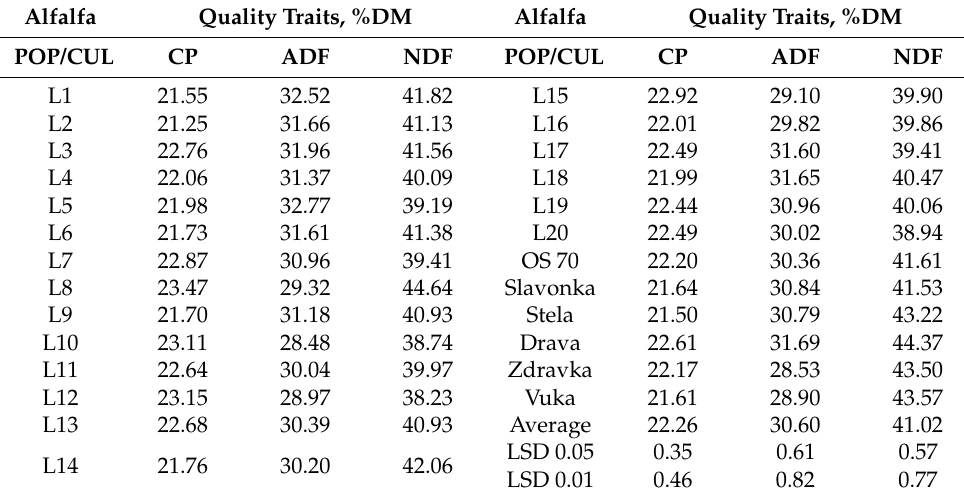
Table 2. Forage quality traits of the investigated alfalfa populations/cultivars in the second cut of the second growing season at the late bud to early flowering stage. Alfalfa Quality Traits, %DM Alfalfa Quality Traits, %DM POP/CUL CP ADF NDF POP/CUL CP